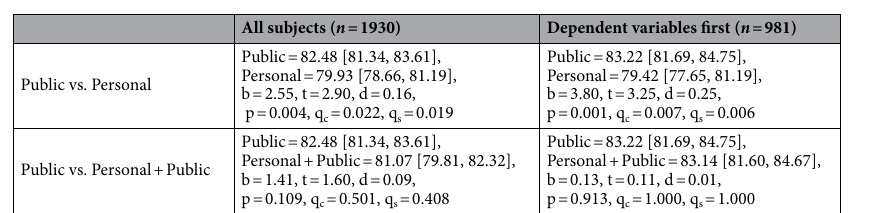
Table 2. Relative effects of the Public treatment on prevention intentions in Studies 1 and 2. We compare the Public treatment to each of our other treatments, across the treatment conditions of Studies 1 and 2 combined. For each comparison, we report mean prevention intentions (with 95% CIs) by condition and the relative effect of the Public treatment (both among all subjects, and subjects for whom we measured our dependent variables